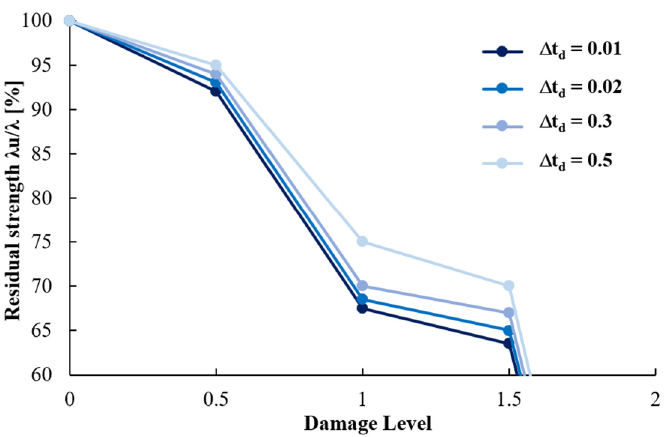
Figure A5. Robustness curves for 2D RC frame structure for location 1: effect of variation of Δ t d (removal time of the column). Δ t d values are expressed in seconds.